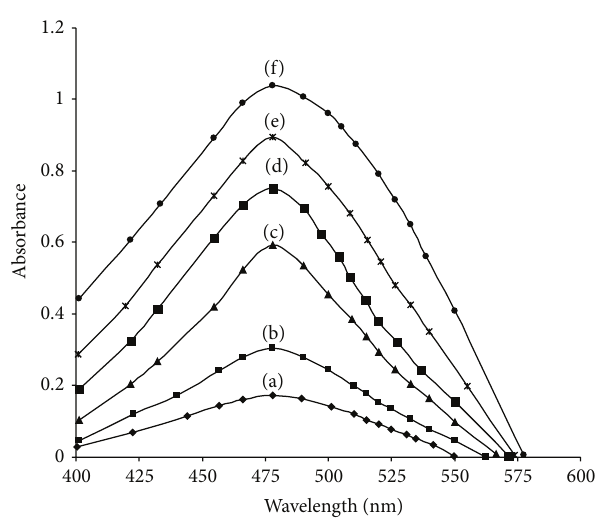
Figure 3: Absorption spectra of the oxidation product against water in the presence of different concentrations of PZT: 1.6mL of KBrO 3 (100 𝜇 g mL −1 ); 1.0 mL of 2.0mol L −1 HCl; 1.4mL of 5 × 10 −3 molL −1 FAS; 2.0mL of 1.0mol L −1 SCN − ; PZT (a) 3.5 𝜇 gmL −1